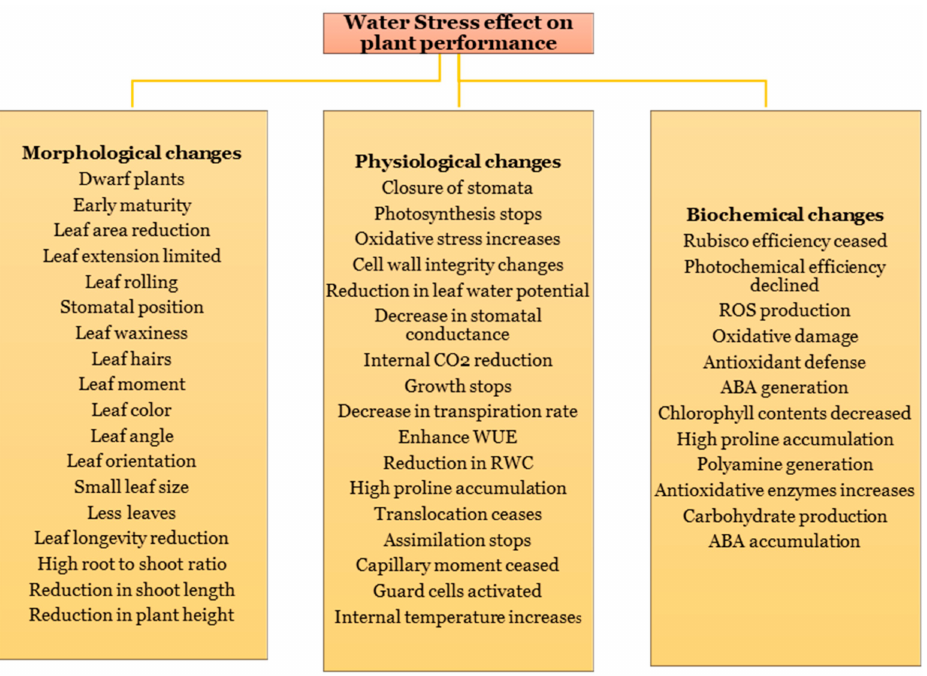
Figure 1. Morphological, physiological and biochemical dynamics of plants affected by water